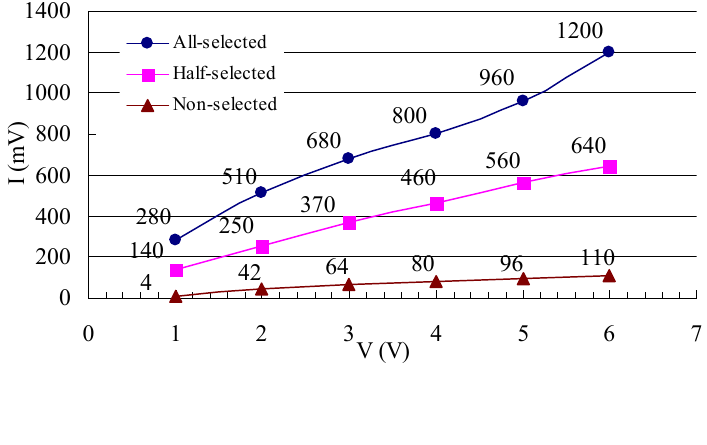
Figure 13. The ±1 st order diffraction light intensity of different pixels when an all-selected pixel is actuated by 1V to 6V square-waves